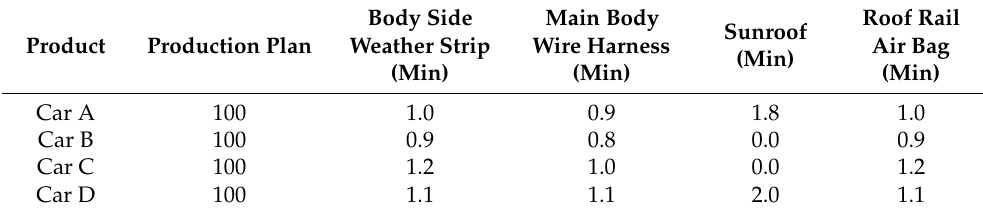
Table 3. Processing time settings of each product in Case A.